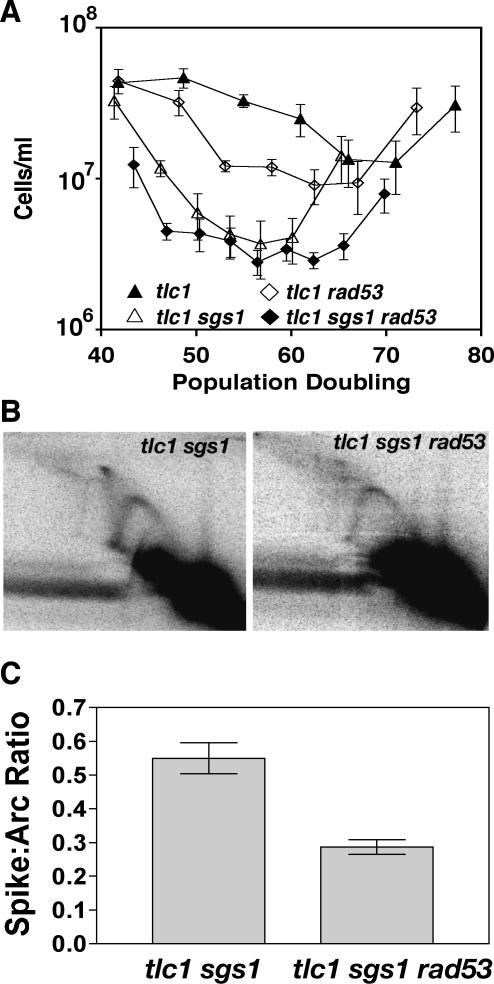
Dependence of Senescence and X-Structures on RAD53
(A) Effect of sgs1 deletion and the rad53K227A kinase–defective allele on the senescence of tlc1 mutants. Senescence rates were measured in liquid assays for spore products of the indicated genotypes derived from a diploid that was triply heterozygous for tlc1, sgs1, and rad53K227A mutations. Each value is the mean and standard error of four independent spore products.(B) DNA was isolated from tlc1 sgs1 and tlc1 sgs1 rad53K227A mutants at PD 55 and analyzed as in Figure 1B.(C) Mean spike:arc ratios for three independent examples each of PD 55 tlc1 sgs1 and tlc1 sgs1 rad53K227A mutants were 0.55 ± 0.05 and 0.29 ± 0.02, respectively, p < 0.007)